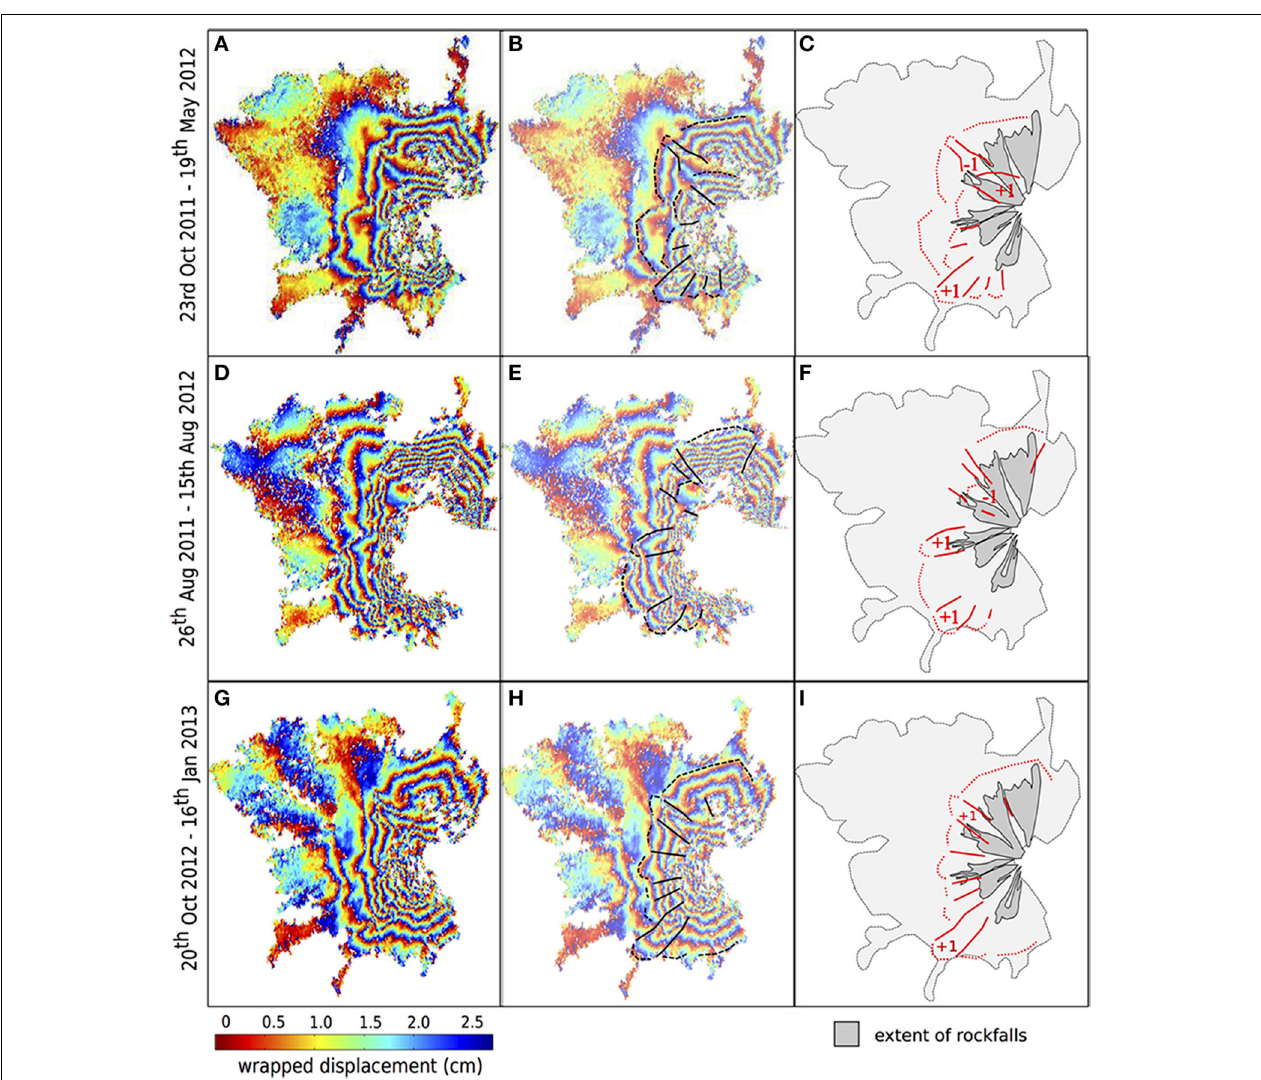
FIGURE 4 | Examples of independent, coherent > 3 months interferograms (A,D,G) used to identify distinct sliding units. Discontinuities and offset in fringes are outlined in solid black on (B,E,H) . The estimated extent of the sliding units (end of tight fringe pattern) are indicated by black dotted lines. The same boundaries are shown in red on the schematic